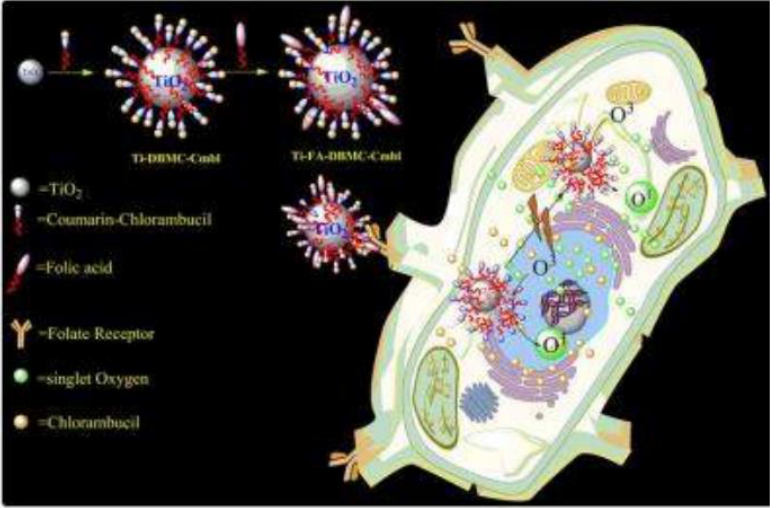
Figure 8. PDT and chemotherapeutic effects of Ti-FA-DBMC-Cmbl NPs on MDA-MB BC cells. Reprinted with permission from reference [129] . Copyright 2015 Royal Chemical Society.